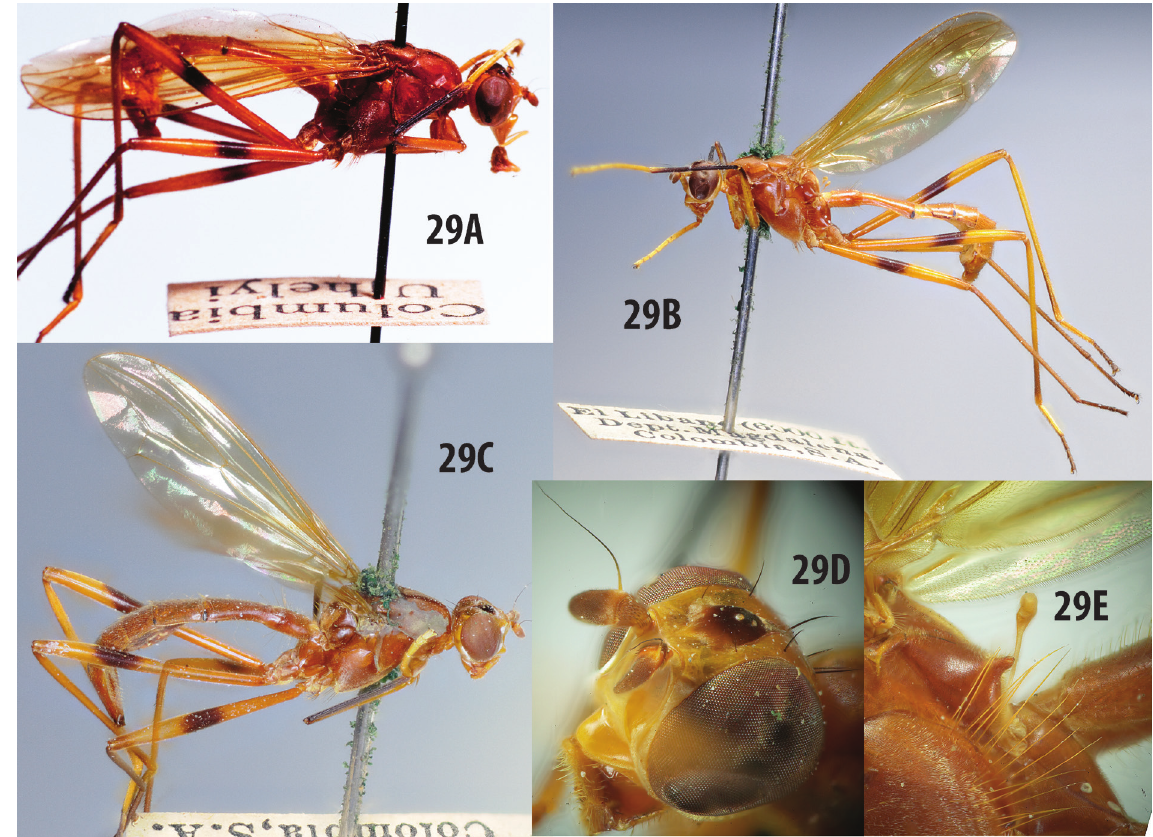
Fig. 29. Mesoconius ujhelyianus Enderlein, 1922 . A . Holotype, ♂, MNBG. B . ♂ (CMNH). C . ♀ (CMNH). D . Head, ♀. E . Katatergite,